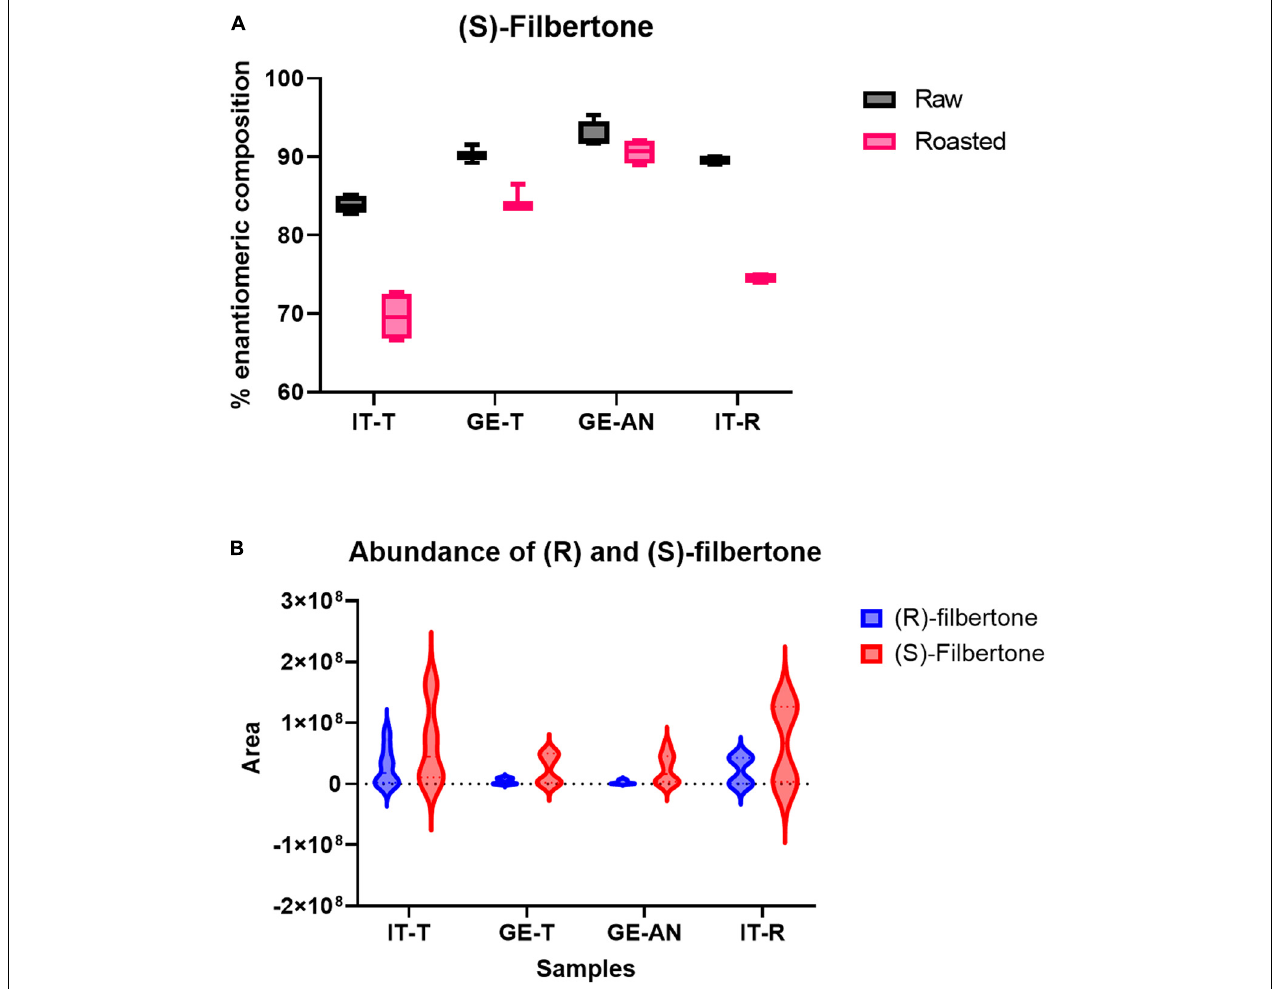
FIGURE 5 | (A) Percentage enantiomeric composition of ( S )-Filbertone in raw and roasted hazelnut from Tonda Gentile Trilobat a harvested in Italy and Georgia (IT-T and GE-T), Tonda Gentile Romana harvested in Italy (IT-R), and Anakliuri harvested in Georgia (GE-AN). (B) Violin plot of raw areas of ( R ) and ( S ) Filbertone (blue and red, respectively) in raw and roasted